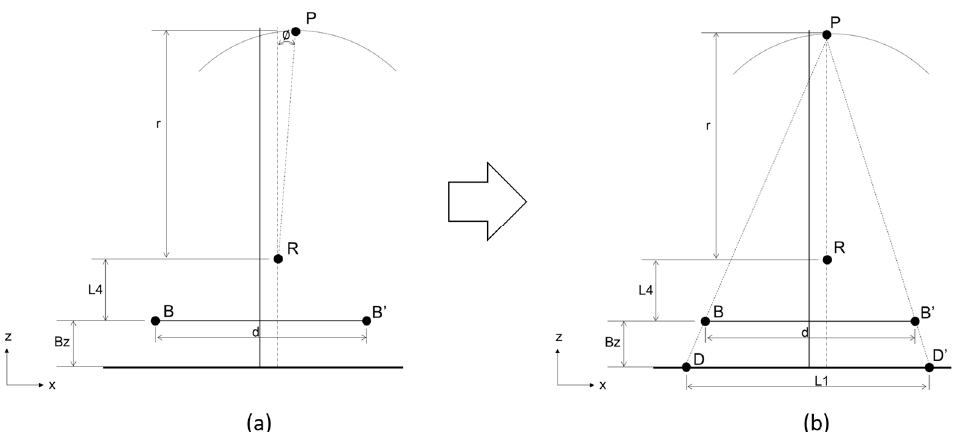
Figure 5. Before Step II is conducted, we rotate the X-ray tube by - ψ ° (calculated from step I): specifically, we adjust the focal spot to the position in which its linking line with the rotation axis is orthogonal to the sensor. ( a ) Original position of the X-ray tube. First, rotate the X-ray tube by - ψ ° (calculated from Step I). ( b ) Hardware positions after adjustment. The focal spot is adjusted to where its linking line with the rotation axis is orthogonal to the sensor.